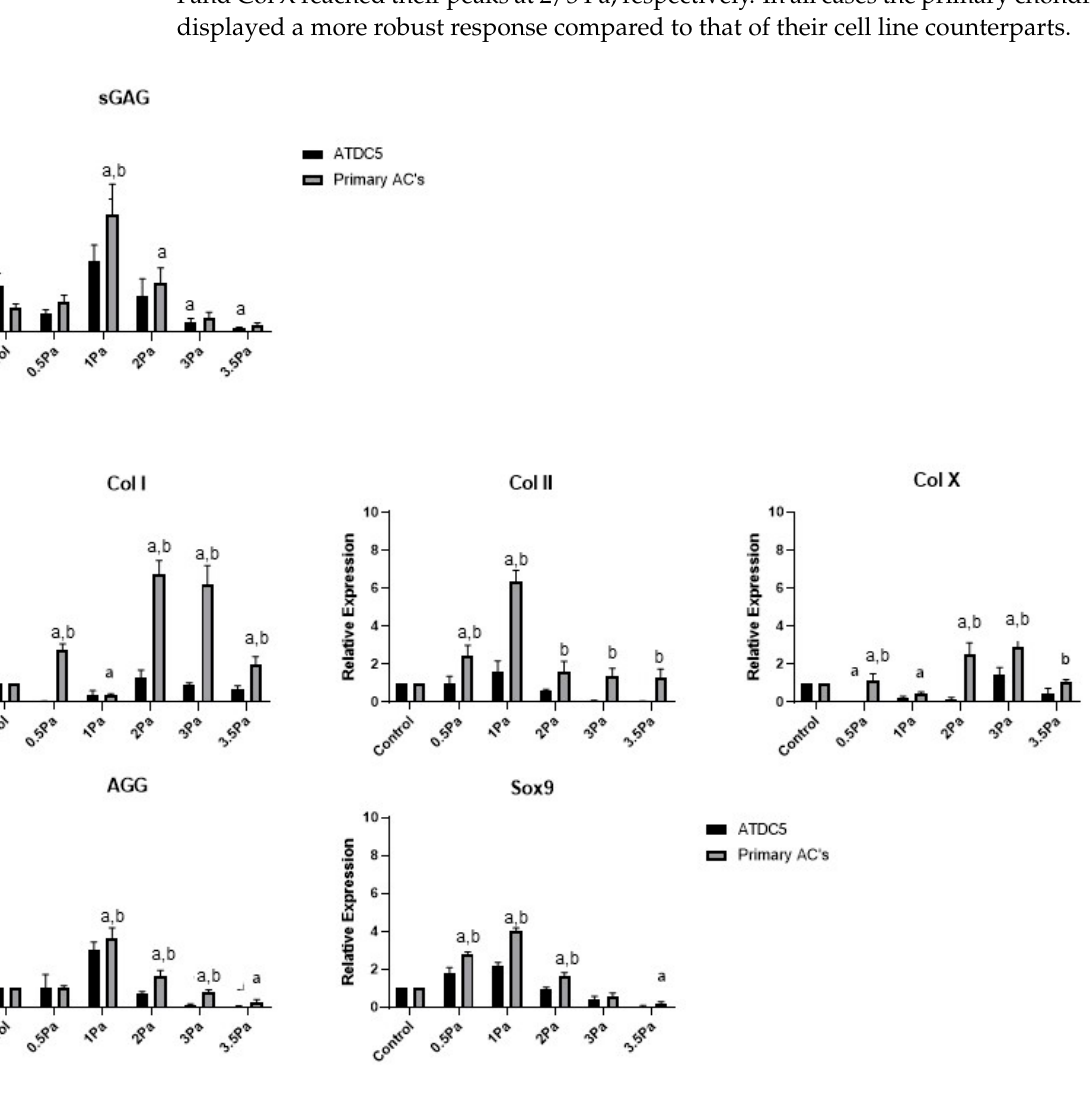
Figure 3. Effect of varying levels of FFSS on primary ACs and ATDC5 cells. ( A ) sGAG levels of both cell types normalized to DNA content. ( B ) Gene expression levels for collagen type I, II, and X, SOX9, and aggrecan mRNA via RT-PCR. Expression data were calculated using the 2 −ΔΔ Ct method relative to baseline levels and normalized using 18S as endogenous control. All regimes were carried out at a frequency of 1 Hz for a duration of 1 h. Statistical differences are shown where (a) represents significant difference compared with respective control/no-flow conditions, at a level of p < 0.05 and (b) represents significant difference compared with cell-line counterpart under identical FFSS conditions, at the level of p <